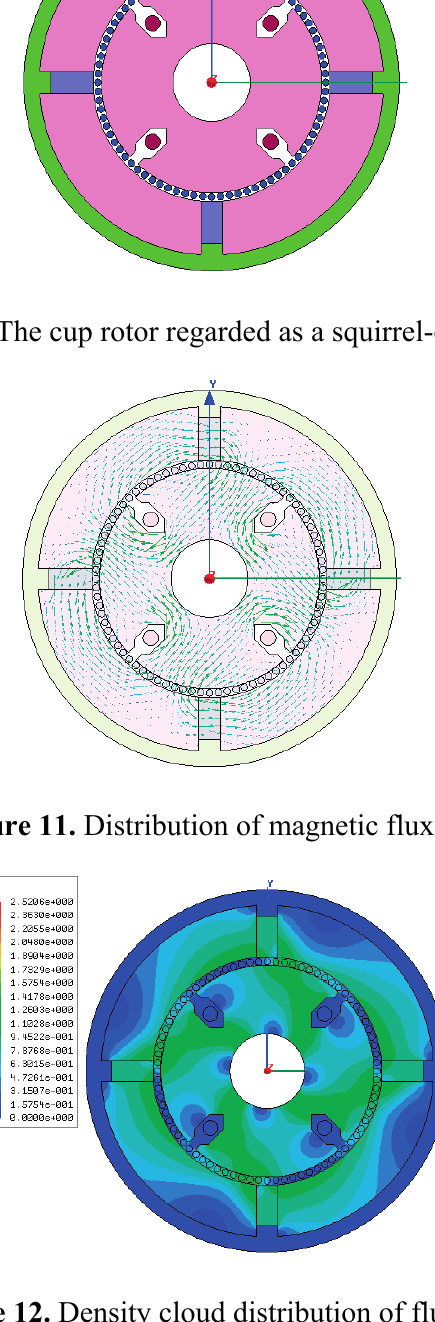
Figure 12. Density cloud distribution of flux Ф